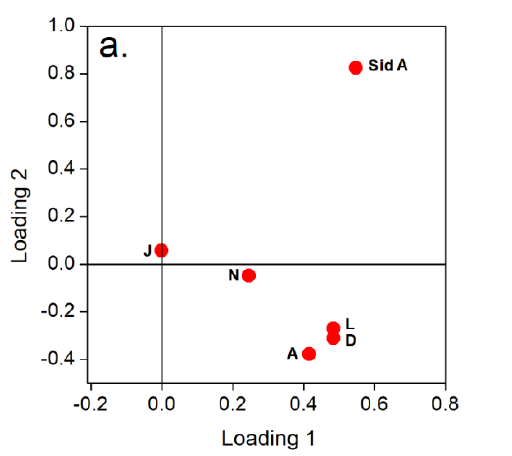
Figure 4. Principal component analysis (PCA) of FPCs as affected by wounding and O 3 treatments in E. globulus leaves—loading ( a ) and score plot ( b ). Individual FPCs concentrations across the recovery period were used in this analysis. The O + W in (b) corresponds to the combined O 3 and wounding treatment. Abbreviations: A, macrocarpal A; D, macrocarpal D; J, macrocarpal J; L, macrocarpal L; N, macrocarpal N; and Sid A, sideroxylonal